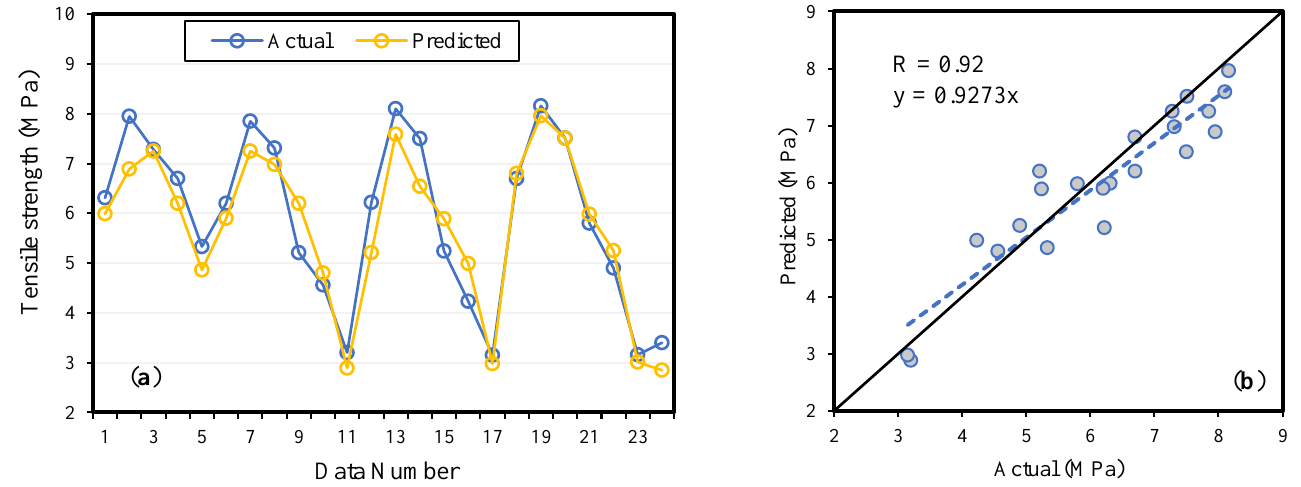
Figure 7. Splitting tensile strength (f STS ) model validation by experimental results ( a ) variation in data ( b ) scattered plot.